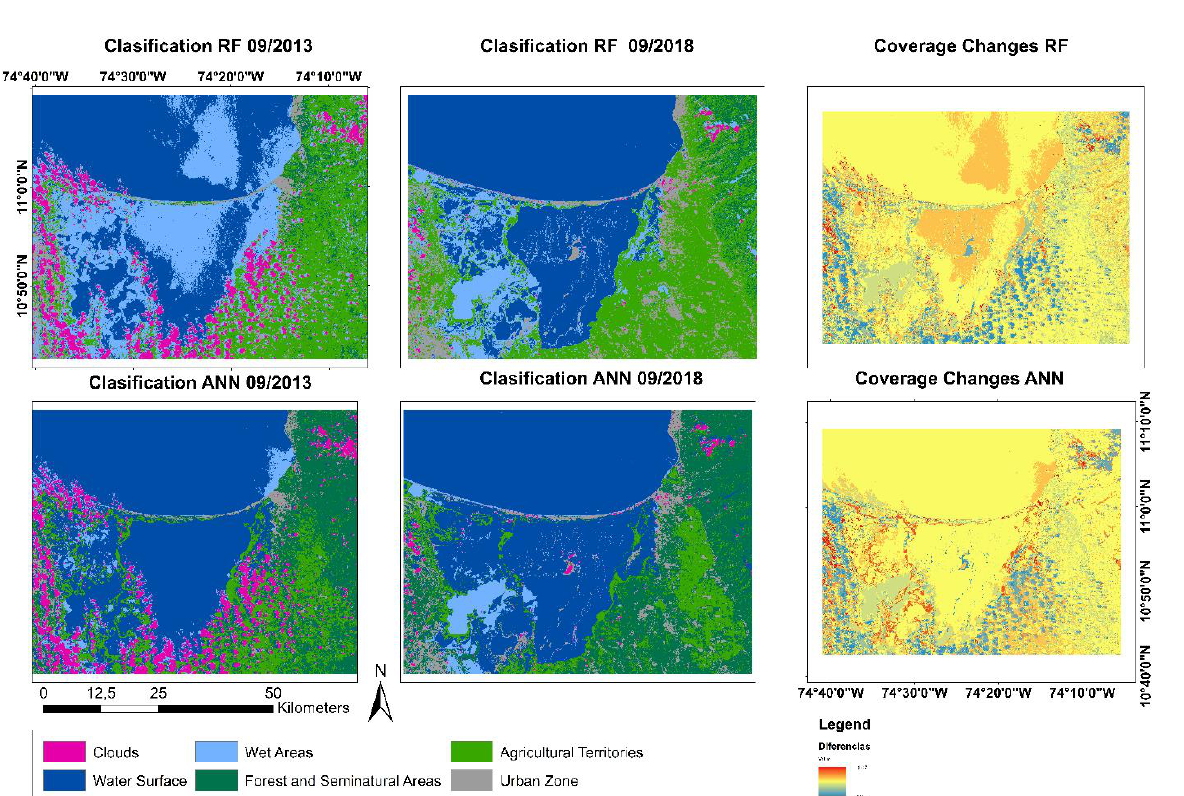
Fig. 4. Classification and changes in 2013 and 2018 coverage